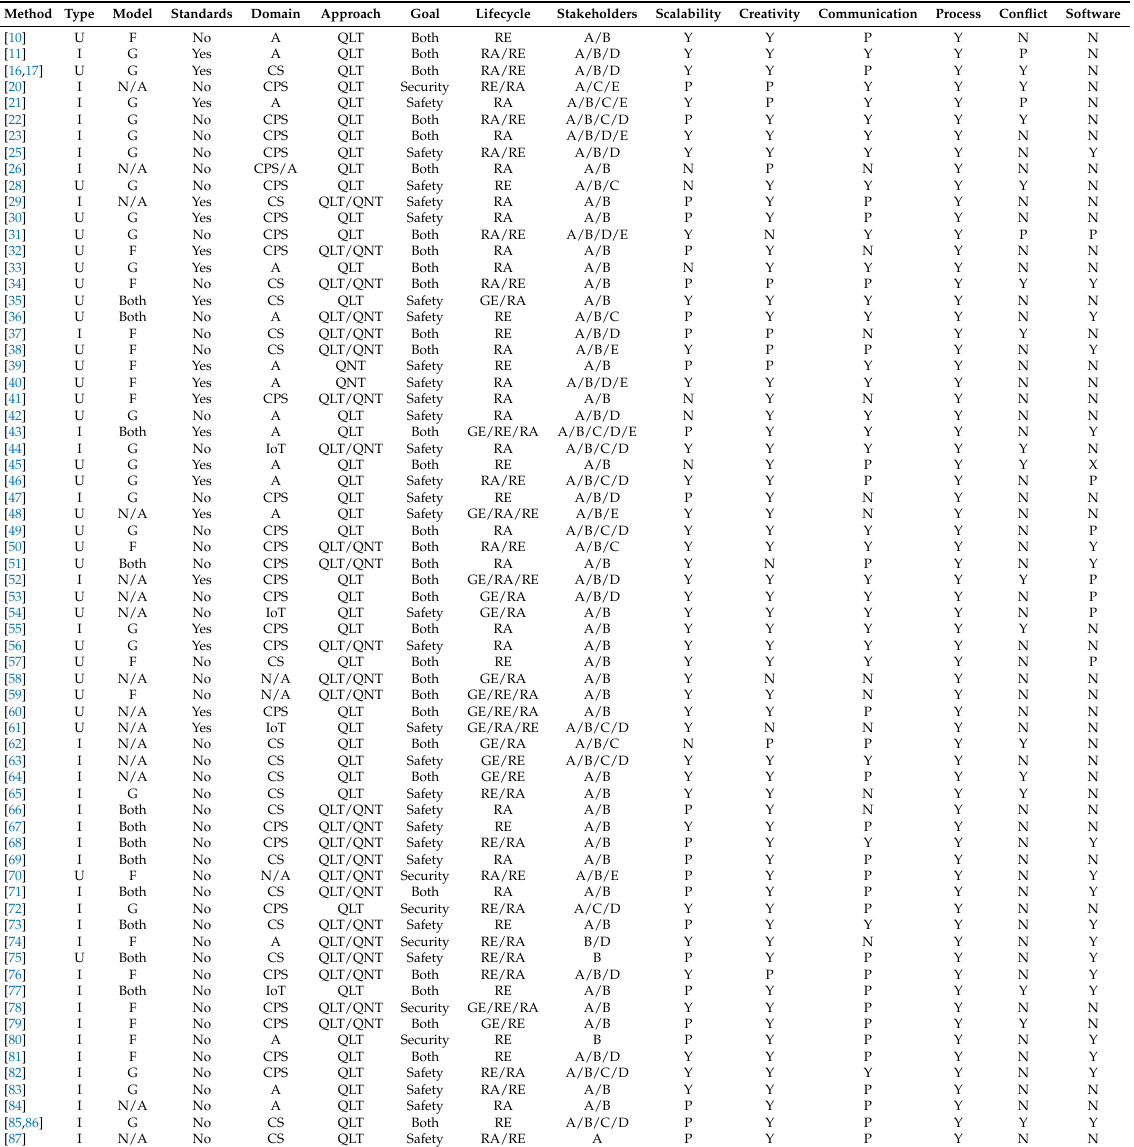
Table 1. Attributes and